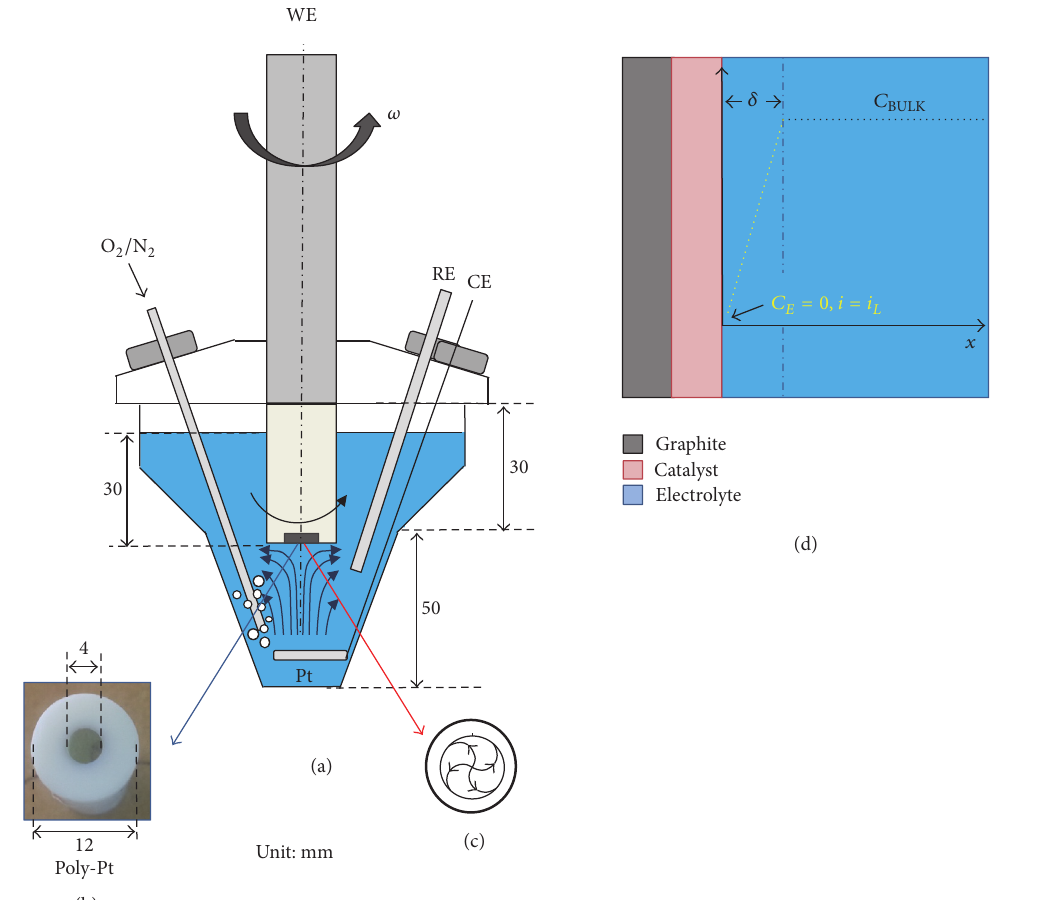
Figure 1: (a) Scheme of the electrochemical cell used for the ORR RDE experiment. (b) Macrograph of the poly-Pt electrode used for benchmark tests. (c) Representative flow lines on the electrode surface under rotation. WE, RE, and CE indicate working, reference, and counter electrodes, respectively. (d) Sketch of the catalyst-electrolyte interface depicting the linear O 2 diffusion model that is incorporated in the K–L equation. The dotted line represents the O 2 concentration distribution both in bulk electrolyte (black) and in the boundary layer (yellow). 𝛿 is the boundary layer thickness; 𝐶 BULK and 𝐶 𝐸 are the O 2 concentrations in the bulk and at the solution | catalyst surface, respectively; 𝑖 𝐿 is the O 2 diffusion-limiting